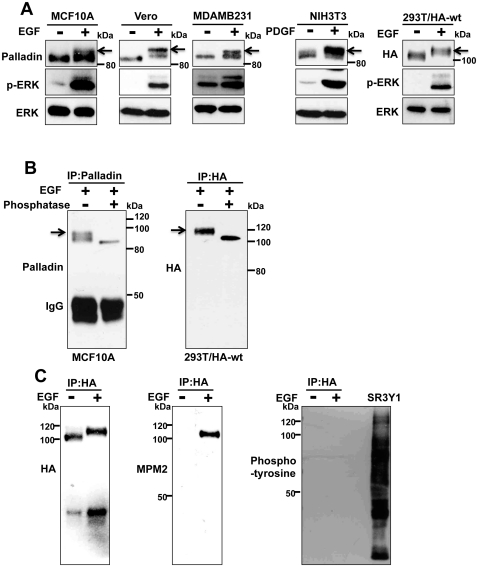
Palladin is phosphorylated upon growth factor stimulation.(A) Indicated cells were serum-starved and stimulated with EGF (20 ng/ml) or PDGF (10 ng/ml). Five min after the stimulation, cells were lysed and probed with anti-palladin or anti-HA antibody. Arrows indicate mobility shifted palladin. (B) Serum-starved MCF10A and 293T/HA-wt cells were treated with EGF and 5 min later cells were lysed with TNE buffer. The lysates were immunoprecipitated with either anti-palladin or anti-HA antibody and incubated with or without alkaline phosphatase for 30 min. Immunoprecipitates were subjected to immunoblotting with the indicated antibody. Arrows indicate mobility shifted palladin. (C) 293T/HA-wt cells were serum-starved and treated or non-treated with EGF for 5 min and then immmunoprecipitated with anti-HA antibody. The immunoprecipitates were probed with the indicated antibodies. Whole cell extract of v-Src transformed cells (SR3Y1) was used as a control for anti-phospho-tyrosine antibody (PY20).